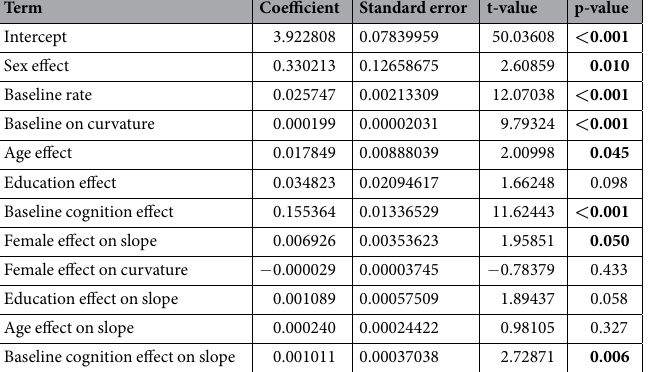
Table 5. Effects of Sex on ADAS-Cog11 change in MCI APOE ε 4 carriers. Baseline cognition indicates ADAS-Cog 11. Bold p -values are statistically significant. Abbreviations: MCI (mild cognitive impairment), ADAS-Cog11 (Alzheimer’s disease assessment scale- cognitive subscale). In this model, the follow-up